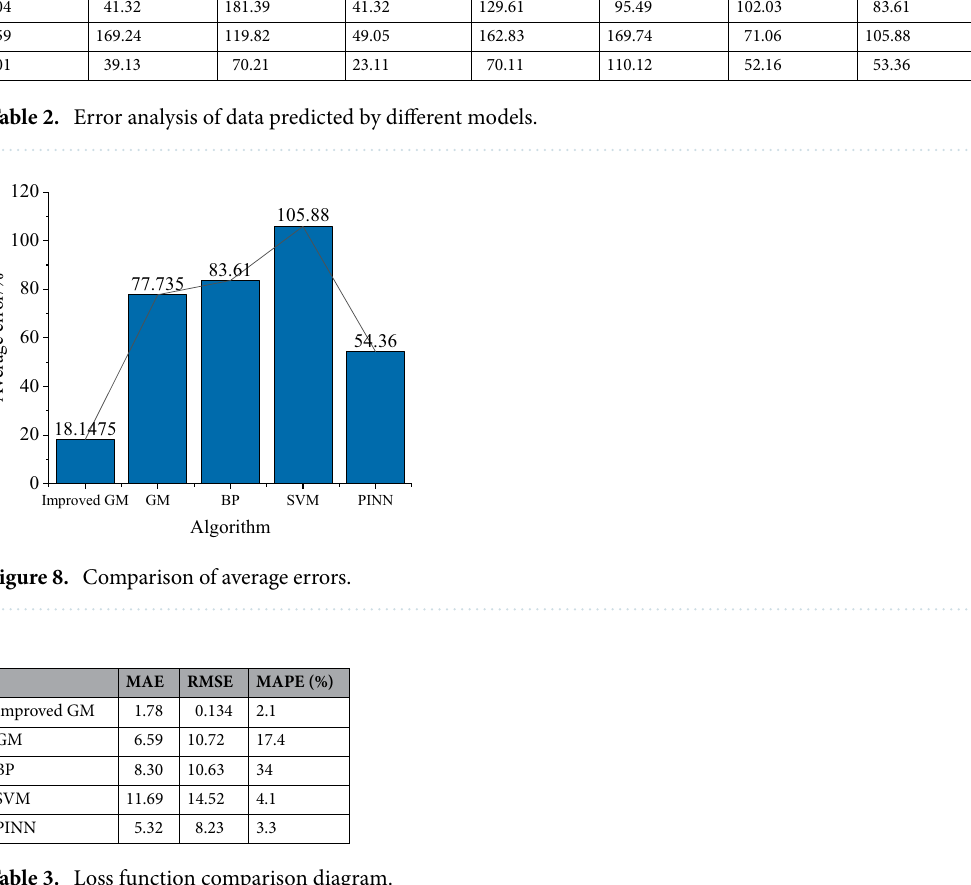
Table 3. Loss function comparison